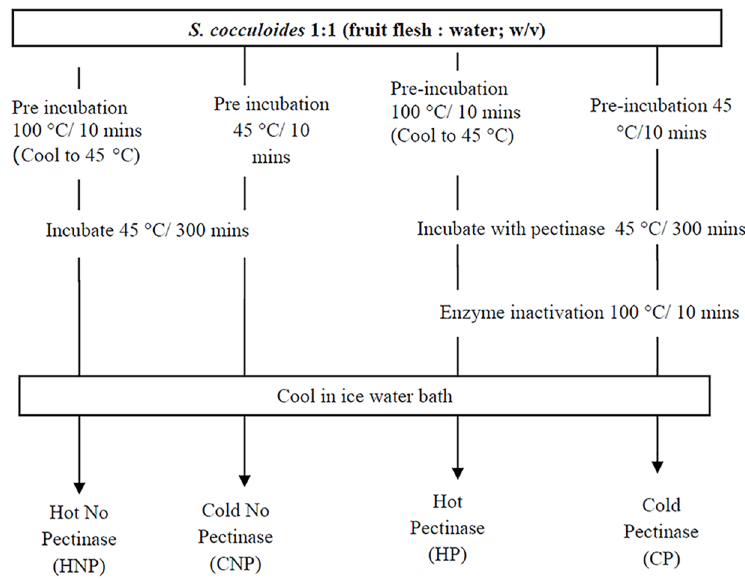
Fig 1. Strychnoscocculoides fruit treatments (HNP, CNP,HP and CP). HNP: Hot water extraction without pectinase, CNP: Cold water extraction without pectinase, HP: Hot water extraction with pectinase, CP: Cold water extraction with